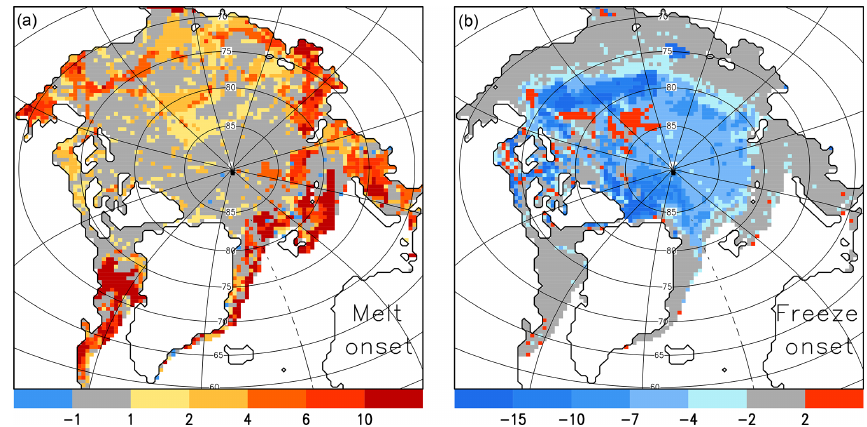
Figure 9. Difference in mean melt onset (a) and freeze onset (b) on days between CICE-best and CICE-default (2010–2017). Positive values mean a later onset day in CICE-best.